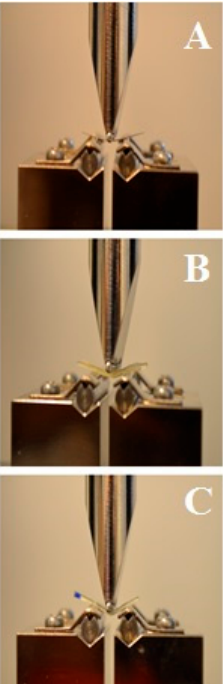
Figure 2. Three point bending test. ( A ) Metal wire, ( B ) fiber reinforced composite (FRC) full coverage, ( C ) FRC no coverage.